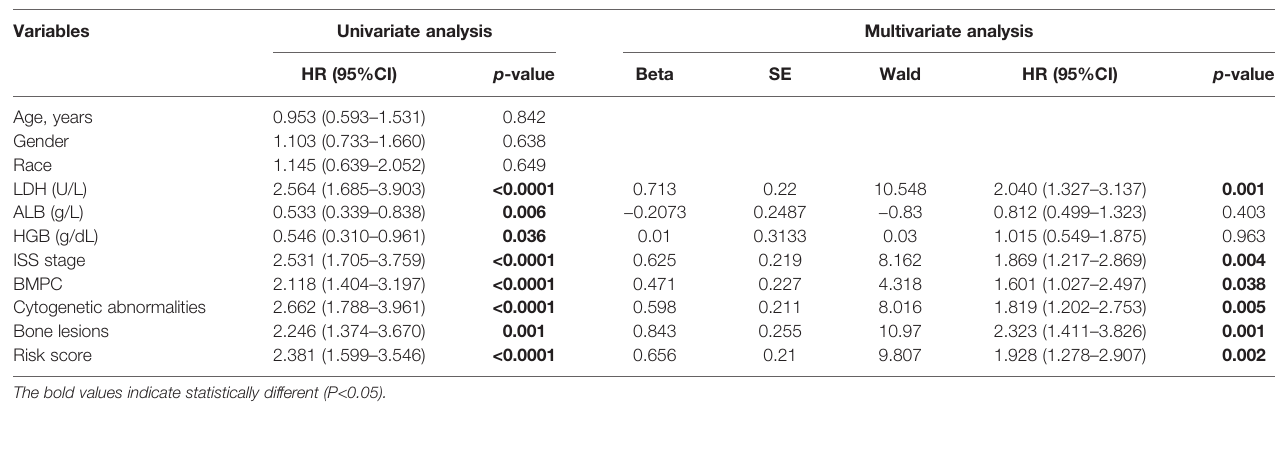
TABLE 1 | Univariate and multivariate analyses of OS using the Cox proportional hazard regression model.